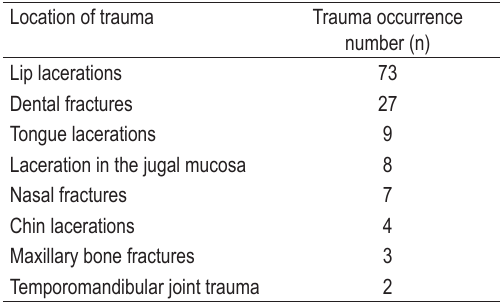
TABLE 2. Distribution of orofacial traumatisms by anatomical